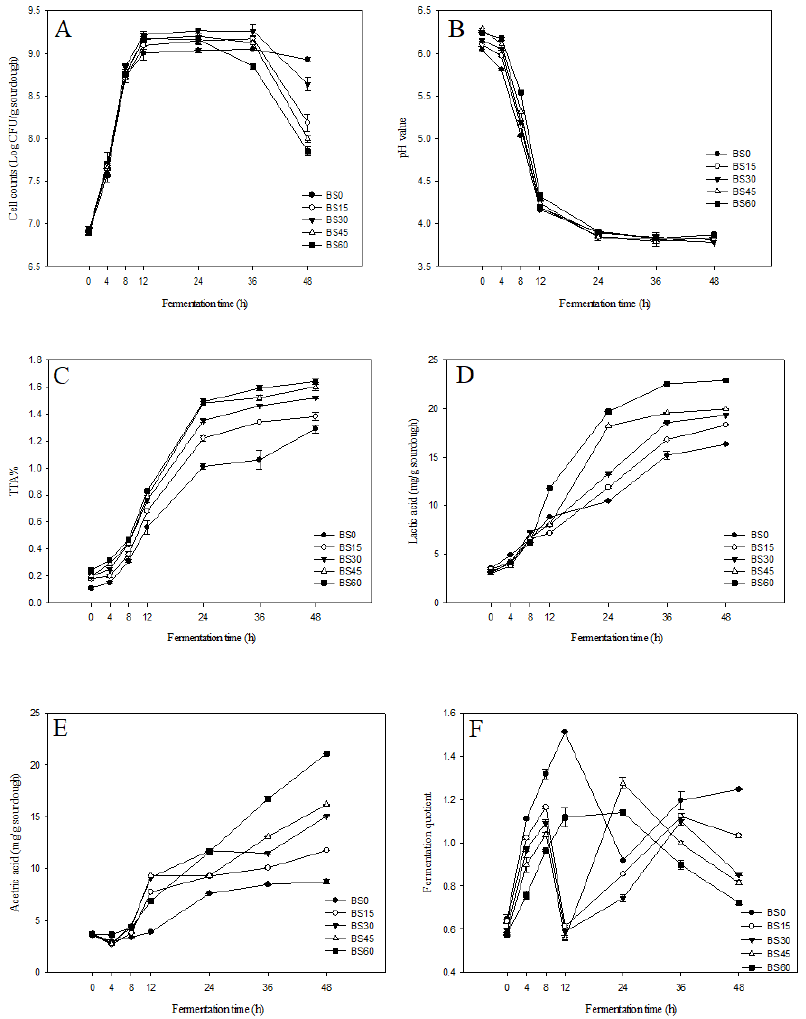
Figure 1. Lactic acid bacteria content ( A ), pH value ( B ), titrate acidic quantity ( C ), lactic acid concentration ( D ), acetic acid concentration ( E ), and fermentation quotient ( F ) of different black rice powder proportions of black rice sourdough fermented by L. brevis LUC 247. BS0: without black rice powder; BS15: with 15% black rice powder; BS30: with 30% black rice powder; BS45: with 45% black rice powder; and BS60: with 60% black rice